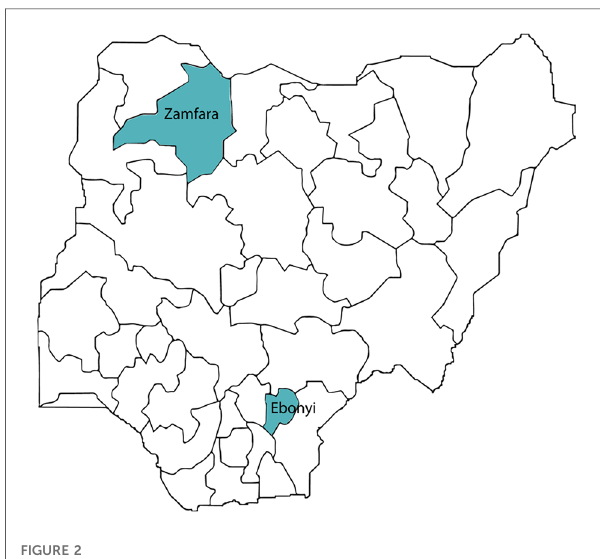
FIGURE 2 Map of Expanding Family Planning Choices project